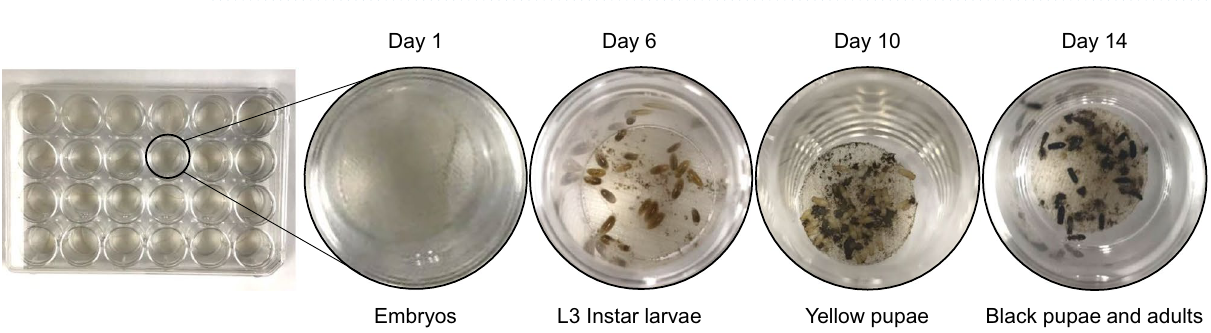
Figure 1. Schematic of the step for Nasonia rearing media (NRMv3).